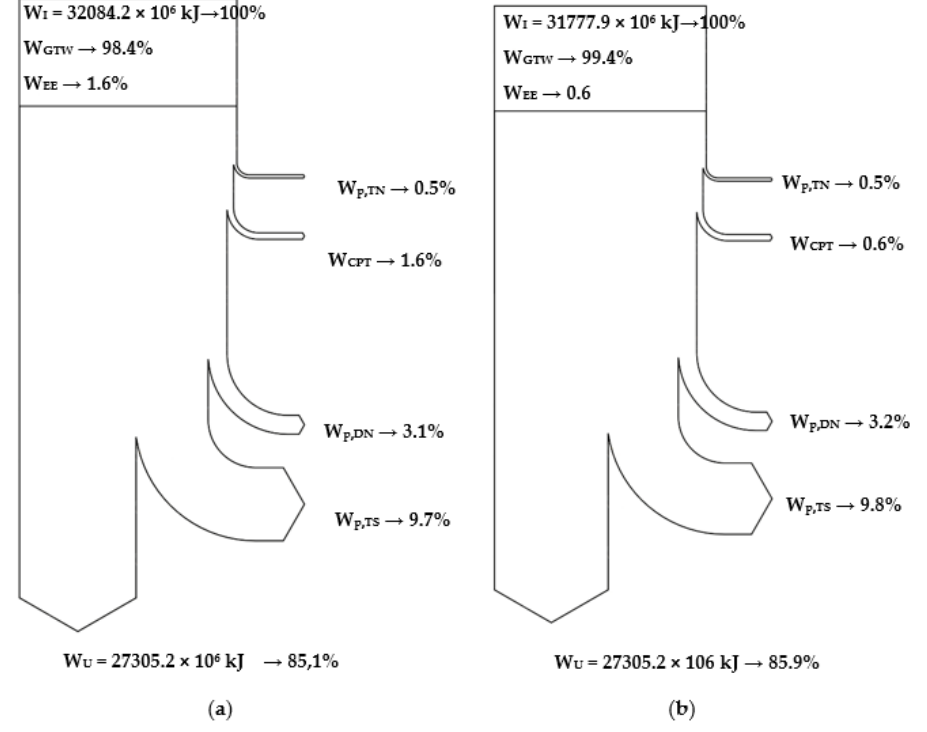
Figure 14. Energy flow diagram of the predicted optimized annual energy balance ( a ) forecast 2020 — Hypothesis 1; ( b ) forecast 2020 — Hypothesis 2.